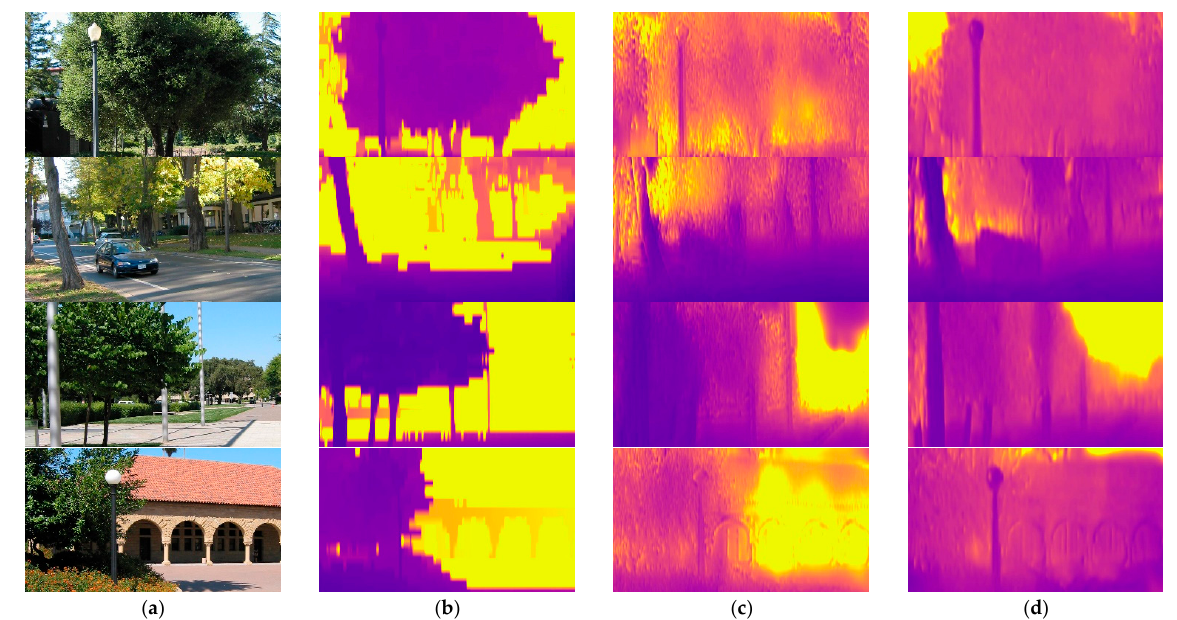
Figure 6. Qualitative samples on the Make3D datasets. ( a ) The input RGB images, ( b ) ground truth depth maps, ( c ) outputs of Godard et al. [29], and ( d ) outputs of the proposed SFA-MDEN.